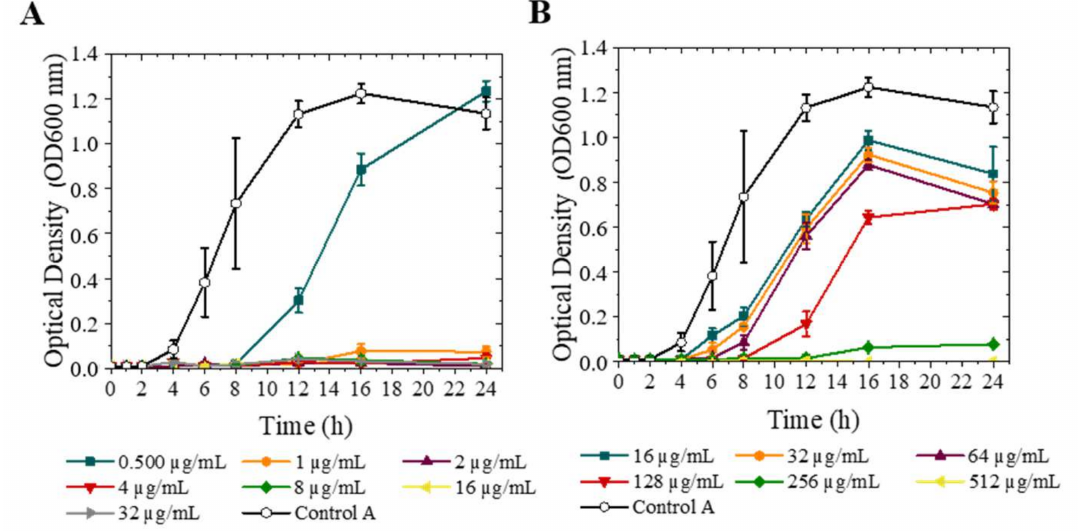
Figure 6. Antibacterial activity of azithromycin microparticles against S. aureus and P. aeruginosa . Control was C.A (bacteria untreated). OD 600 ( A ) S. aureus ; ( B ) P. aeruginosa (mean ± SD, n =